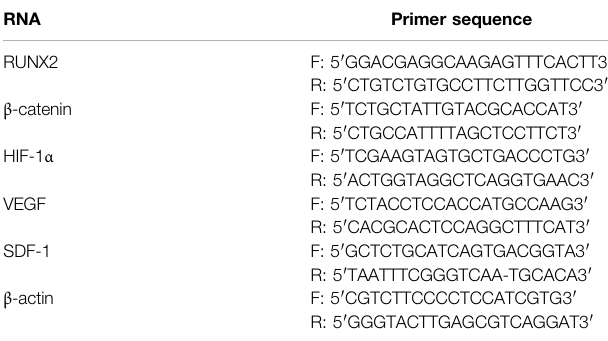
TABLE 1 | RNA primer